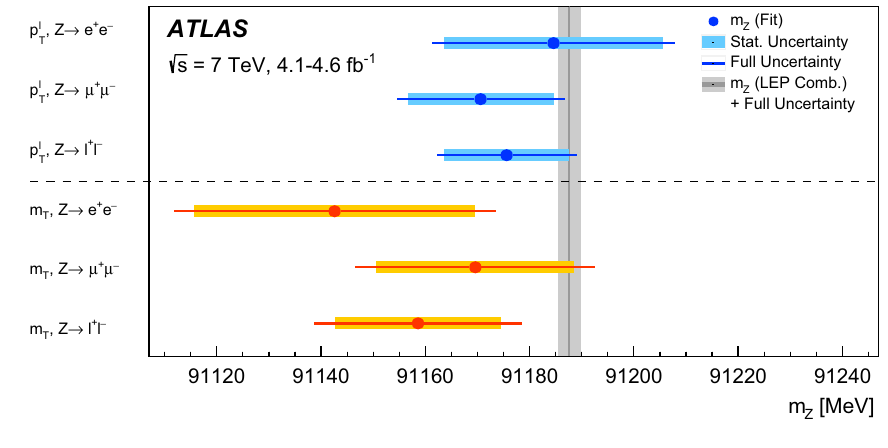
and m T systematic uncertainty, which includes lepton efficiency and recoil cali- T brationuncertaintieswhereapplicable.Physics-modellinguncertainties are